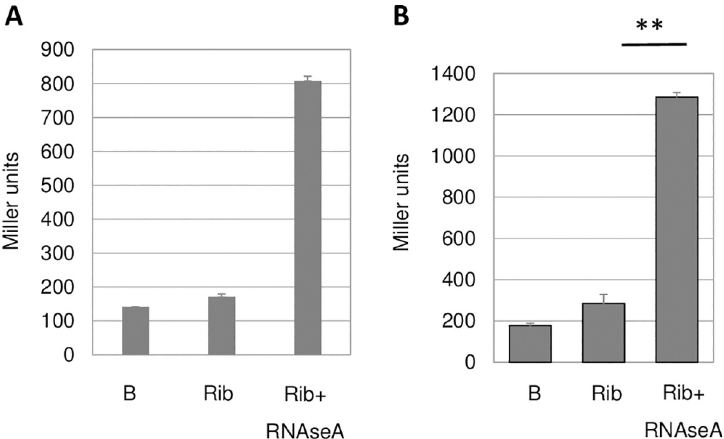
Fig 6. Free RPuL2 has signal activity. RNAseA-promoted dissociation of purified ribosomes (Rib) frees signal activity. Reporter strain is GMI12052 (wt). Panel A: Medicago A17 nodule ribosomes extracted from 100 mg (FW) of nodules. B control buffer. The mean of two experiments is shown. Panel B : Signal activity of purified E . coli ribosomes (NEB P0763S, 0.5mg). P-value 0.0014, t-test, n = 3.